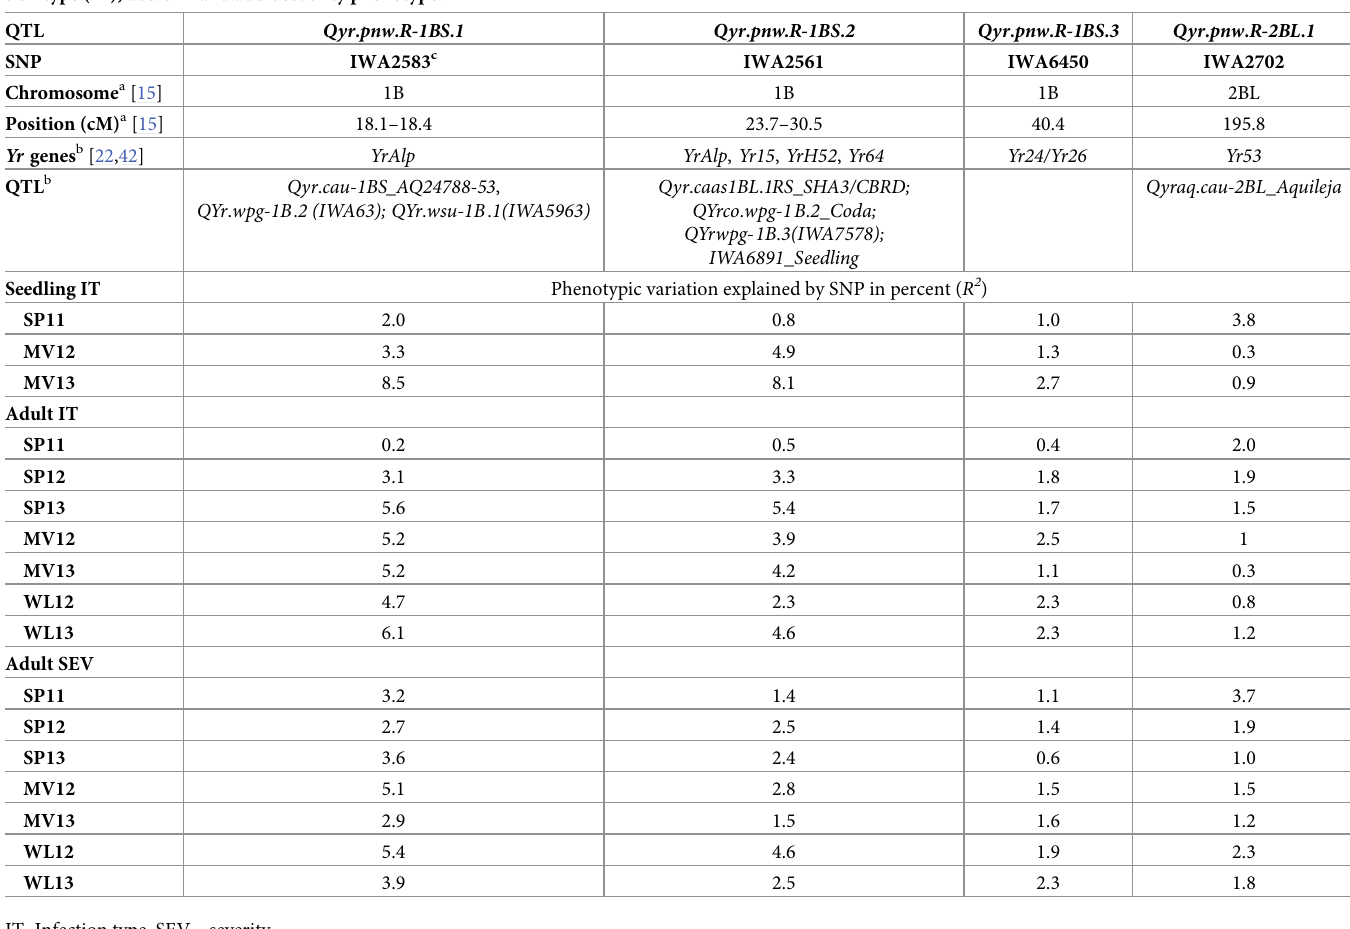
Table 3. Chromosome location, previously reported Yr genes and QTL, and R 2 values of significantly and commonly associated QTL with stripe rust seedling infec- tion type (IT), adult IT and adult severity phenotype. QTL Qyr . pnw . R-1BS . 1 Qyr . pnw . R-1BS .